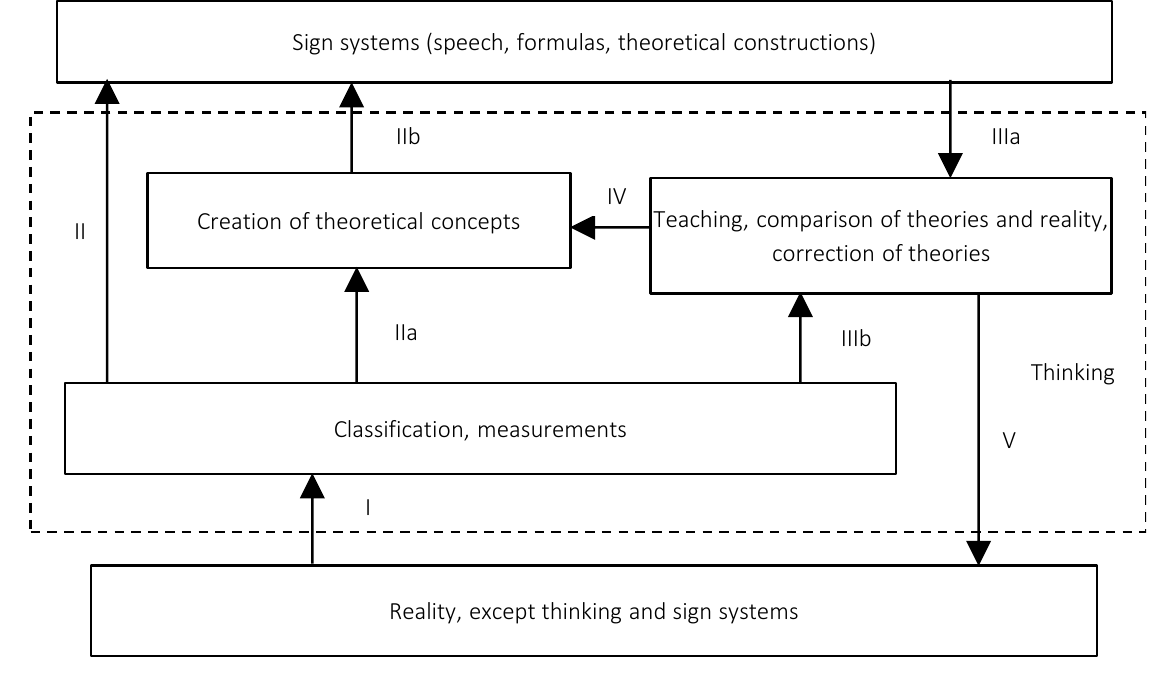
Figure 2. Correlation between thinking, reality, and sign systems